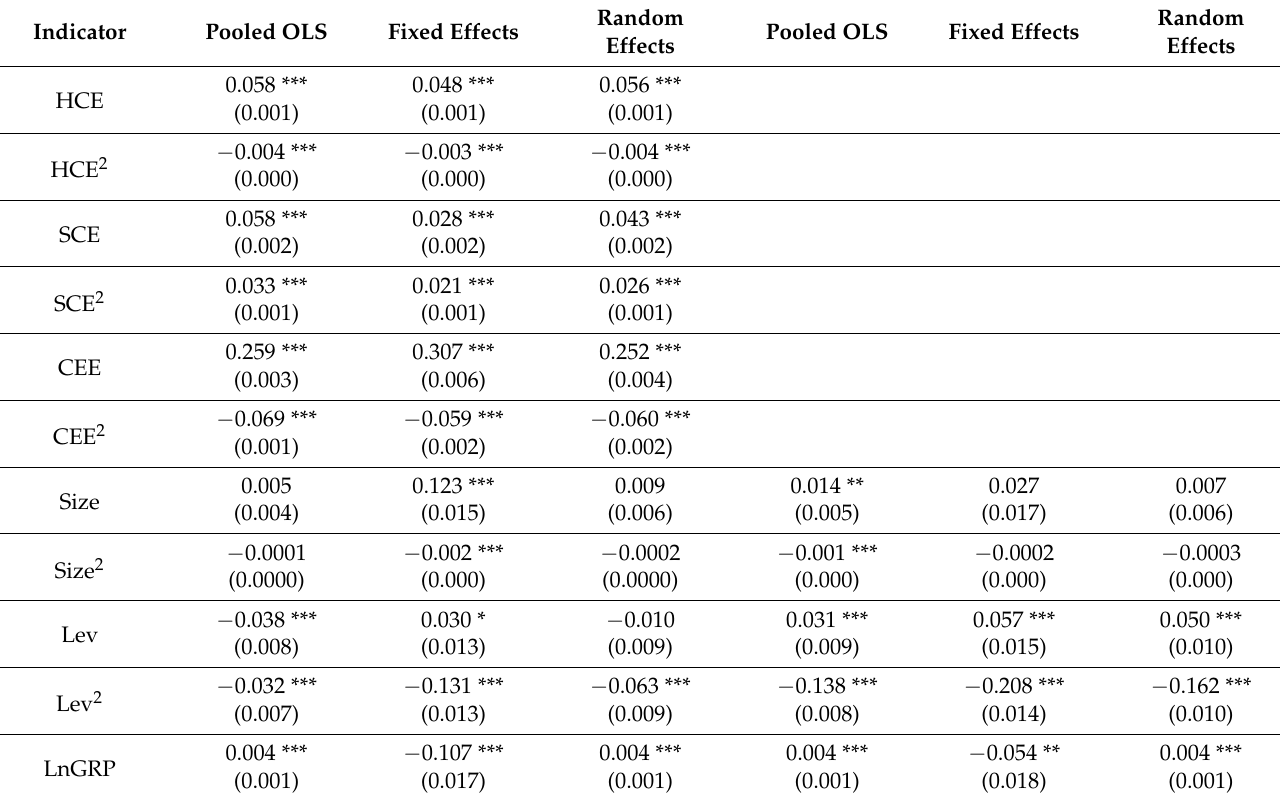
Table 5. Results of regression analysis for models with ROA as the dependent